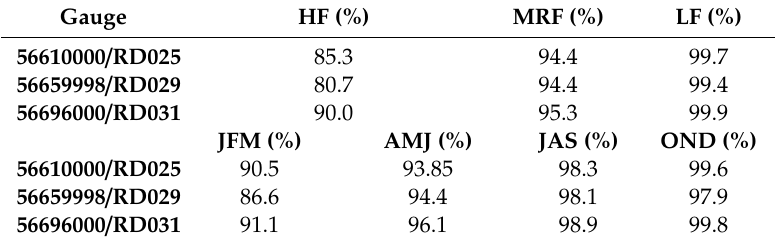
Table 2. Needed E. coli reduction (RD) per regime of flow and per season in the Piracicaba basin. Gauge HF (%) MRF (%) LF (%) 56610000/RD025 85.3